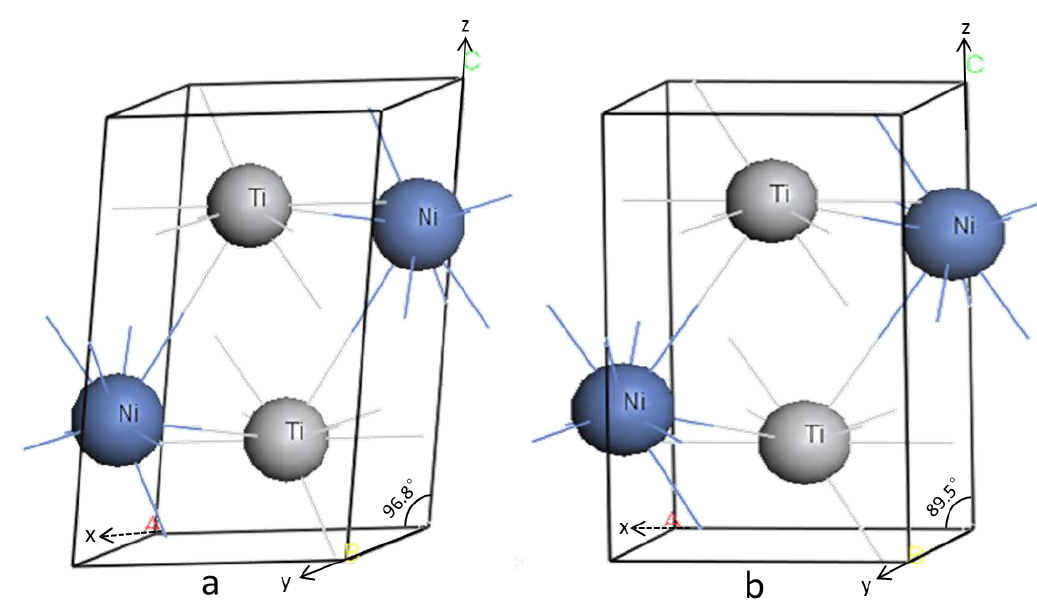
Figure 1. Schematic of the unit cell of ( a ) B19′ martensite structure and ( b ) B19 martensite structure.